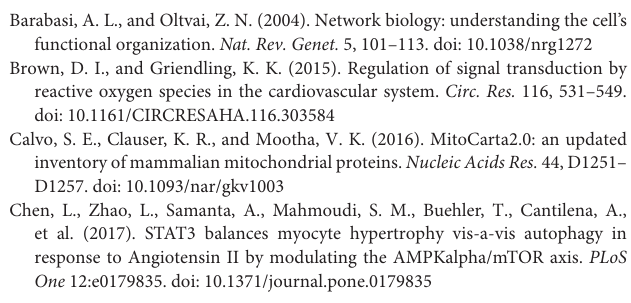
Supplementary Table 3 | Modules detected from PPI network Supplementary Table 4 | Real-time PCR Primer